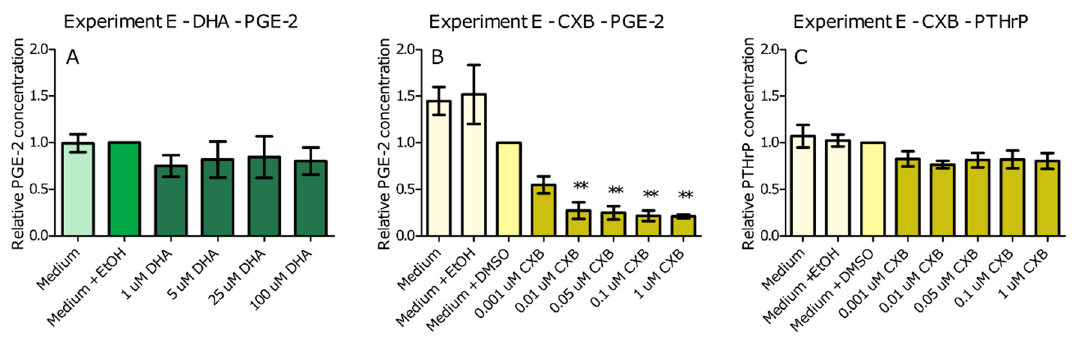
Figure 4. Effect of supplementation of C26 cells with DHA ( A ); and CXB ( B ) on PGE-2 levels; and effect of supplementation of CXB ( C ) on PTHrP levels. Data represent mean ± SEM. *, ** and *** represent significant differences with vehicle control (respectively, p < 0.05, p < 0.01 and p < 0.001).